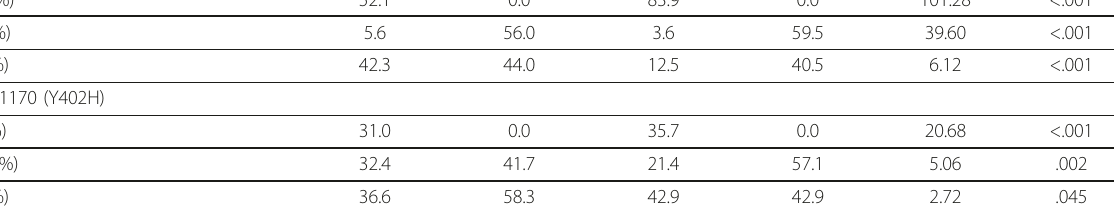
discriminating between segments. The risk genotype for this marker was only modestly differentiating (F = 5.06,